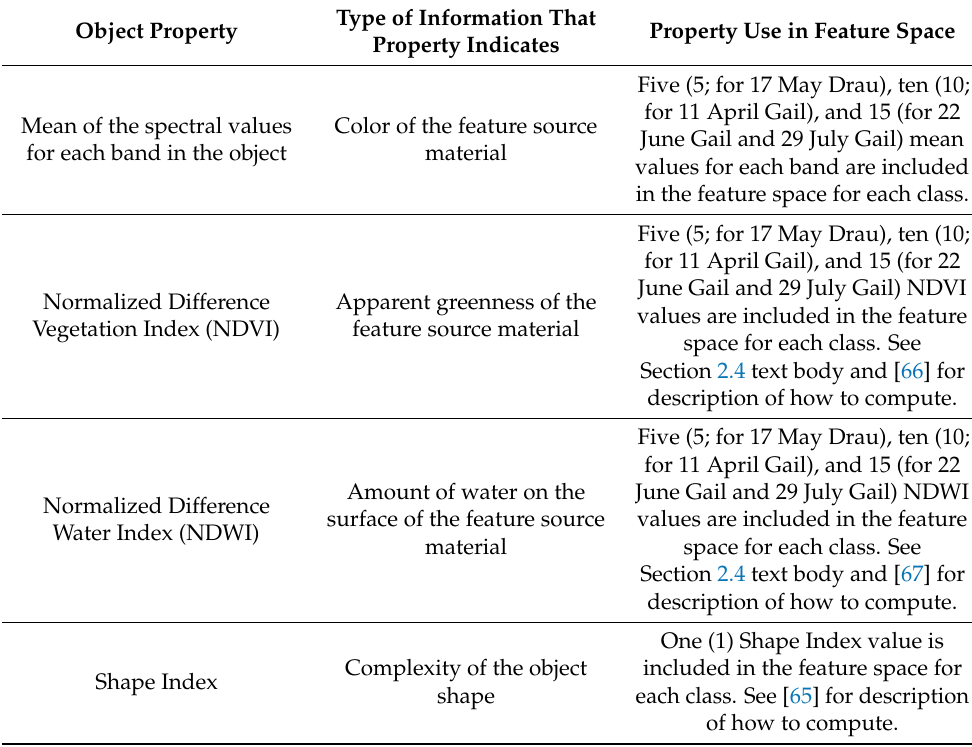
Normalized Difference Water Index (NDWI)